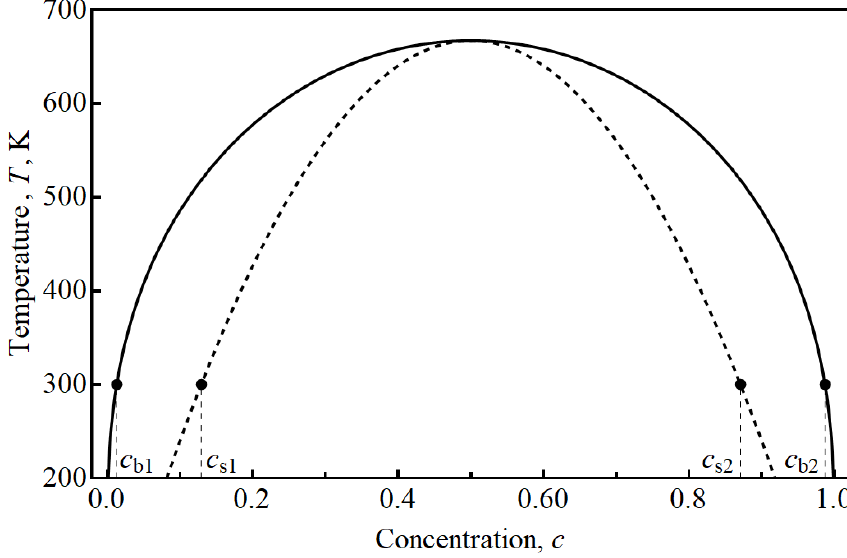
Figure 1. Phase diagram for regular binary solution with interaction parameter of Ω = 0.115 eV/atom.